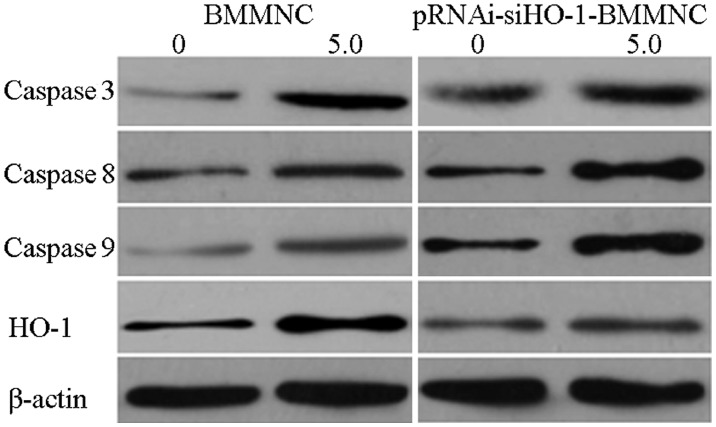
Expression of HO-1 and caspase-3, -8 and -9 proteins. Following treatment with 5 μg/ml DNR, the expression levels of caspase-3, -8 and -9 proteins in the pRNAi-siHO-1-BMMNC group were higher than those in the BMMNC group, whereas HO-1 protein expression was silenced. The differences in protein expression were statistically significant (P<0.05). HO-1, heme oxygenase-1; DNR, daunorubicin; BMMC, bone marrow mononuclear cell.